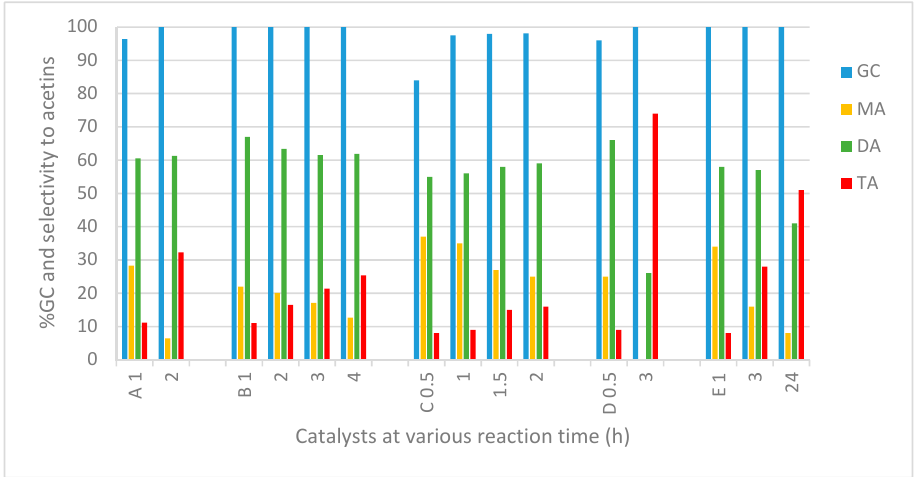
Figure 11. Influence of the reaction time on glycerol conversion (GC) and the selectivity to monoacetin (MA), diacetin (DA) and triacetin (TA), using di ff erent catalysts at various reaction conditions (A = HSiW / ZrO 2 , glycerol (G):acetic acid (AAc) 1:10, T = 120 ◦ C, CL = 0.3 g [131]; B = glycerol-based carbon, G:AAc 1:4, T = 115 ◦ C, CL = 5 wt%G [126]; C = CsPWA, G:AAc 1:8, T = 85 ◦ C, CL = 7 wt%G [89]; D = arenesulfonic acid-functionalized bentonite, G:AAc:toluene 1:7:1.4, T = 100 ◦ C, CL = 0.074 wt%G [147]; E = SBA–propyl sulfamic acid, G:AAc 1:3, T = 105 ◦ C, CL = 50 mg